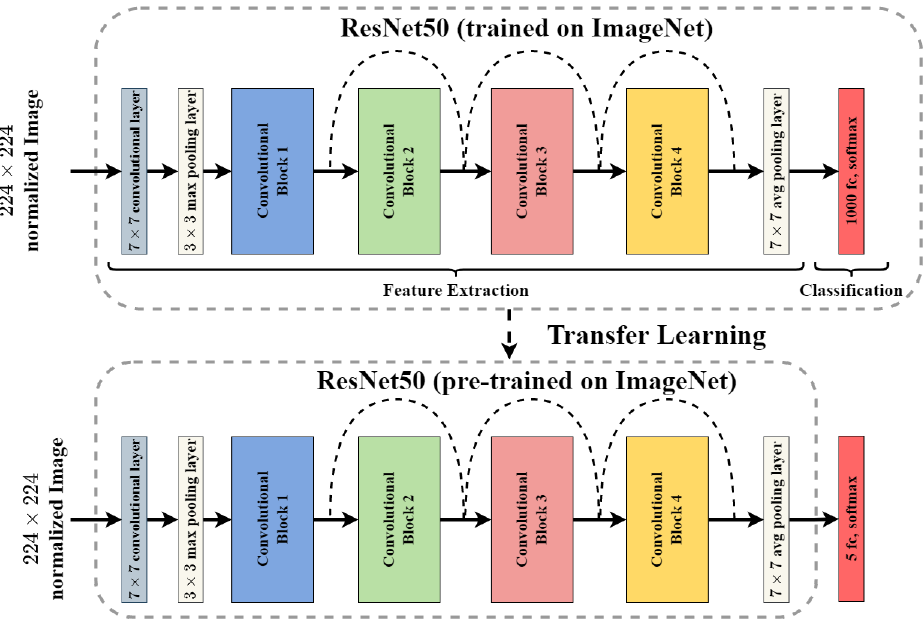
Figure 5. Schematic block diagram of ResNet50 and transfer learning. Note that the classification layer is replaced with 5 as the number of unique classes in the